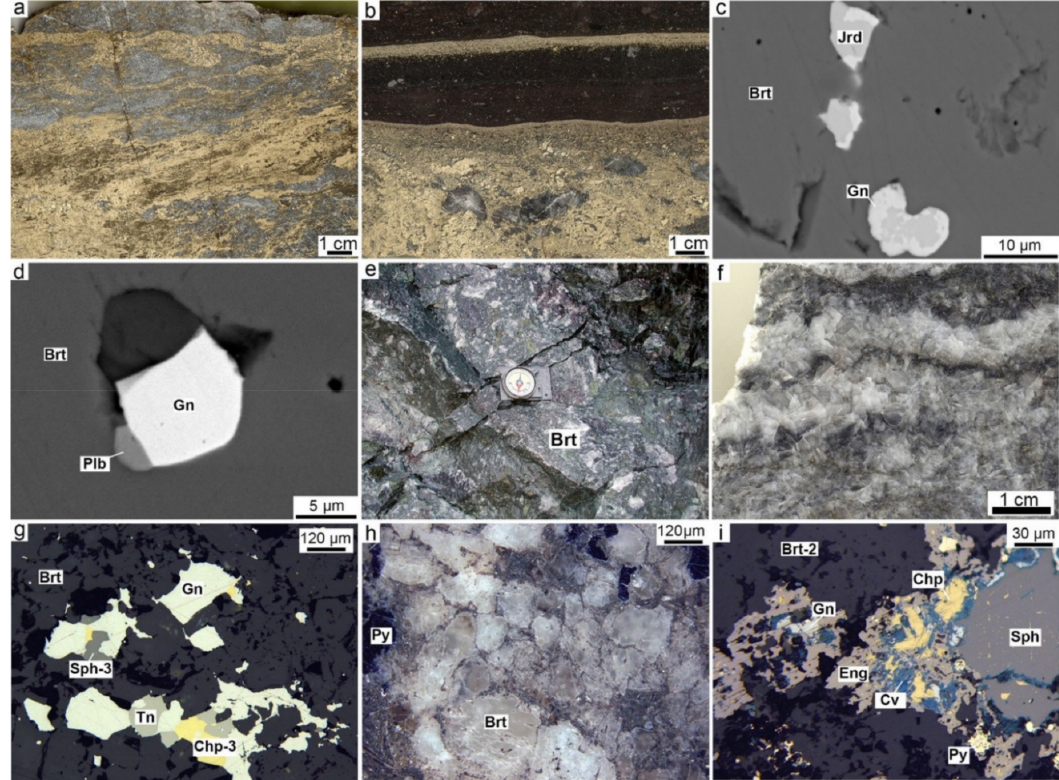
Figure 16. Mineralogical features of barite-rich diagenites of the Molodezhnoe ( a – d ), Aleksandrinskoe ( e – g ) and Saf’yanovskoe ( h – i ) deposits: ( a ) Intercalation of barite and pyrite layers; ( b ) fragments of barite in sulfide turbidite crowned by gossanites; ( c ) jordanite–galena intergrowth in barite; ( d ) polybasite–galena aggregate in barite; ( e ) layers of barite breccias between clastic pyrite and gossanites; ( f ) barite-rich diagenite; ( g ) galena–tennantite–chalcopyrite–sphalerite assemblage in barite; ( h ) clastic structure of barite-rich diagenite cemented by sulfides; ( i ) covellite–galena–enargite assemblage formed after chalcopyrite and sphalerite in barite-2. ( a , b , f ) Polished sample, ( e ) field photo, ( g , i ) reflected light, ( c , d ) SEM photo, ( h ) dark field reflected